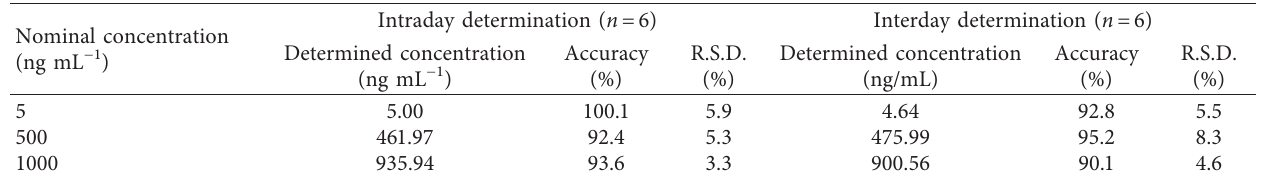
Table 1: Precision and accuracy of apremilast in beagle dog plasma.